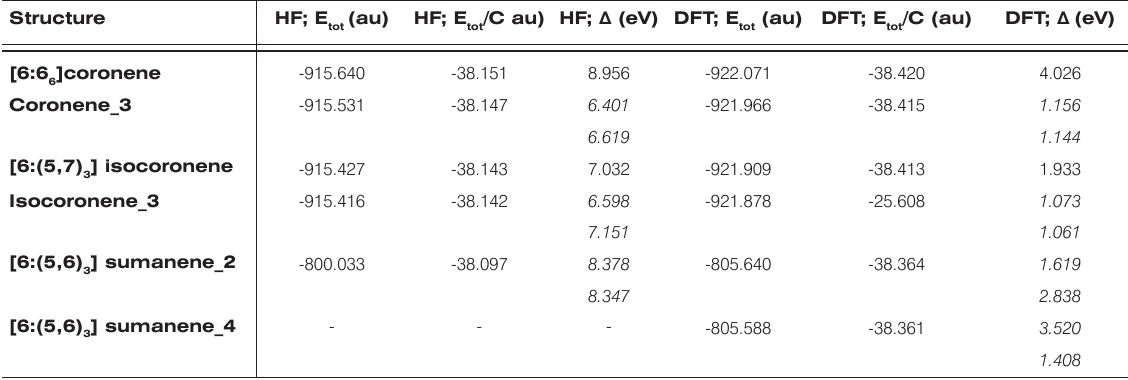
/C and the HOMO-LUMO gaps Δ computed at HF and DFT levels of theory tot